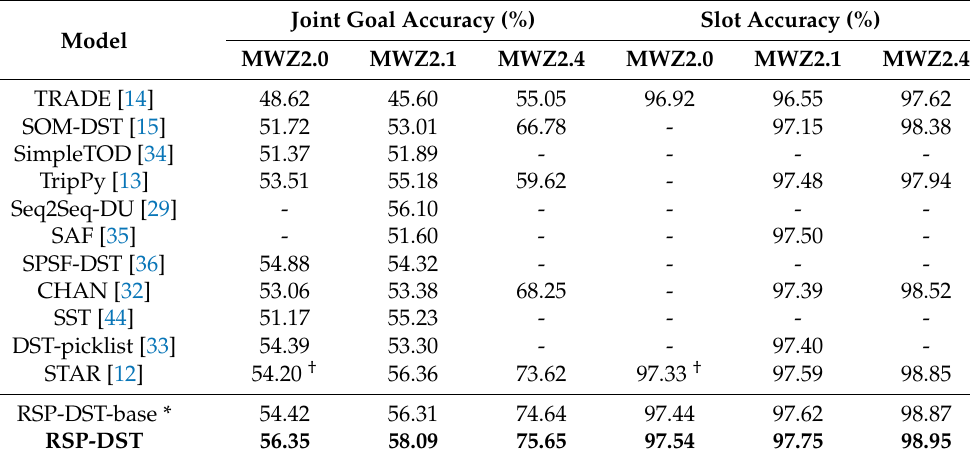
Table 2. Joint goal accuracy of RSP-DST and baselines on test sets of MultiWOZ 2.0, MultiWOZ 2.1, and MultiWOZ